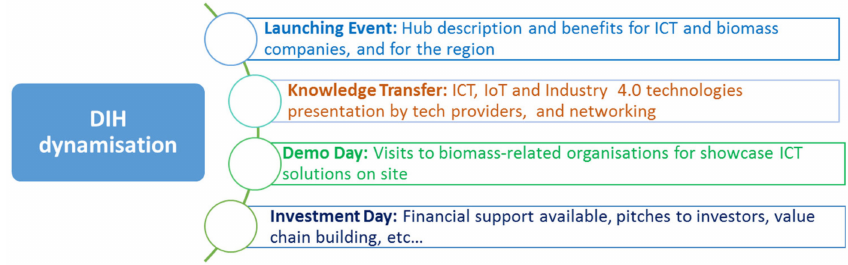
Figure 3. Events foreseen for DIHs’ dynamisation. IoT—Internet of things